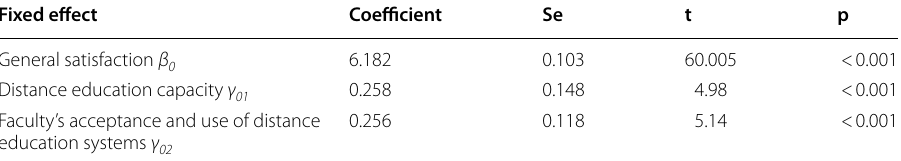
Table 5 University variables random coefficient regression model